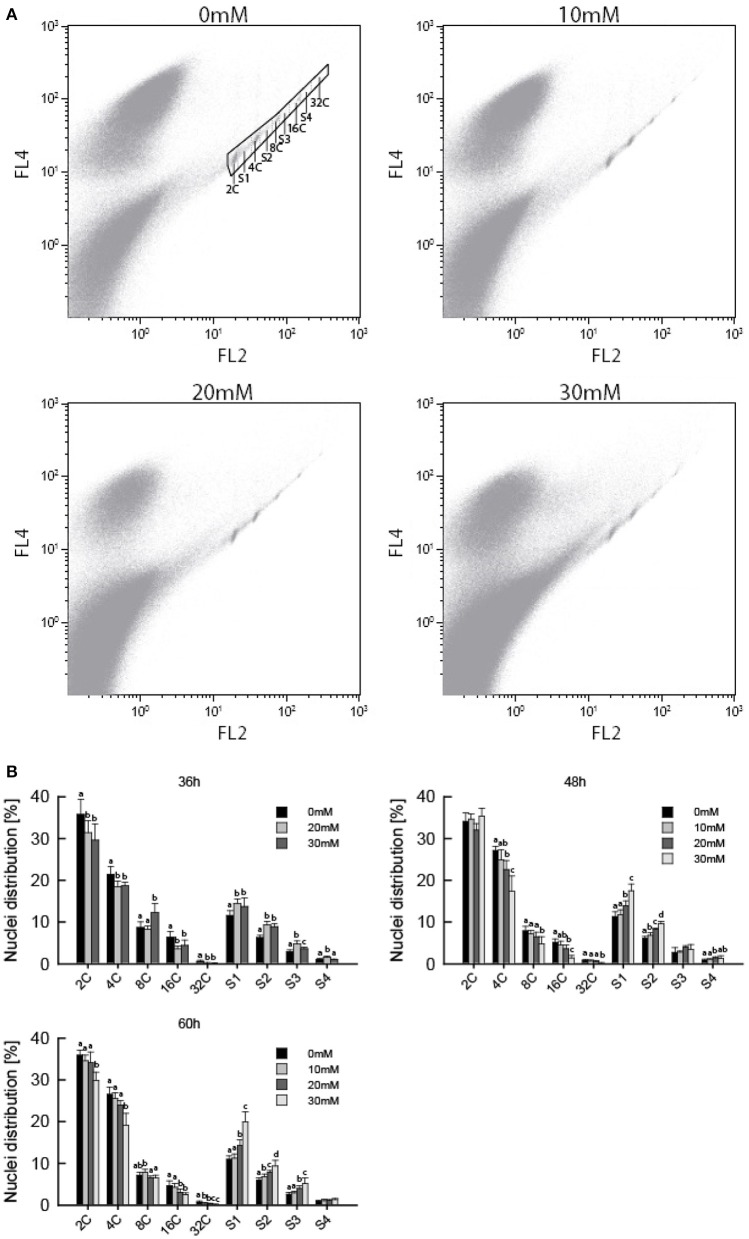
Flow cytometric analysis of A. thaliana nuclei following AITC treatment. Seedlings were subjected to vapor of 0, 10, 20, or 30 mM AITC for 36, 48, and 60 h before cell cycle distribution was analyzed by flow cytometry. (A) Biparametric dot plot of FL2 (575 nm) versus FL4 (695 nm) fluorescene emission with 488 nm exitation as detected by flow cytometry and extracted using the software Kaluza. The plots presented are representative plots from seedlings treated with 0, 10, 20, and 30 mM AITC for 48 h. An example of gating is shown in the 0 mM treatment plot. Gated signals comprised <1% of all signals detected. (B) Percentage of nuclei in each cell cycle phase for all treatments. Different letters indicates statistically significant differences between treatments within the same cell cycle phase, no letters indicates no significant difference. The means of 3 independent experiments with each 2–3 biological replicates are shown.